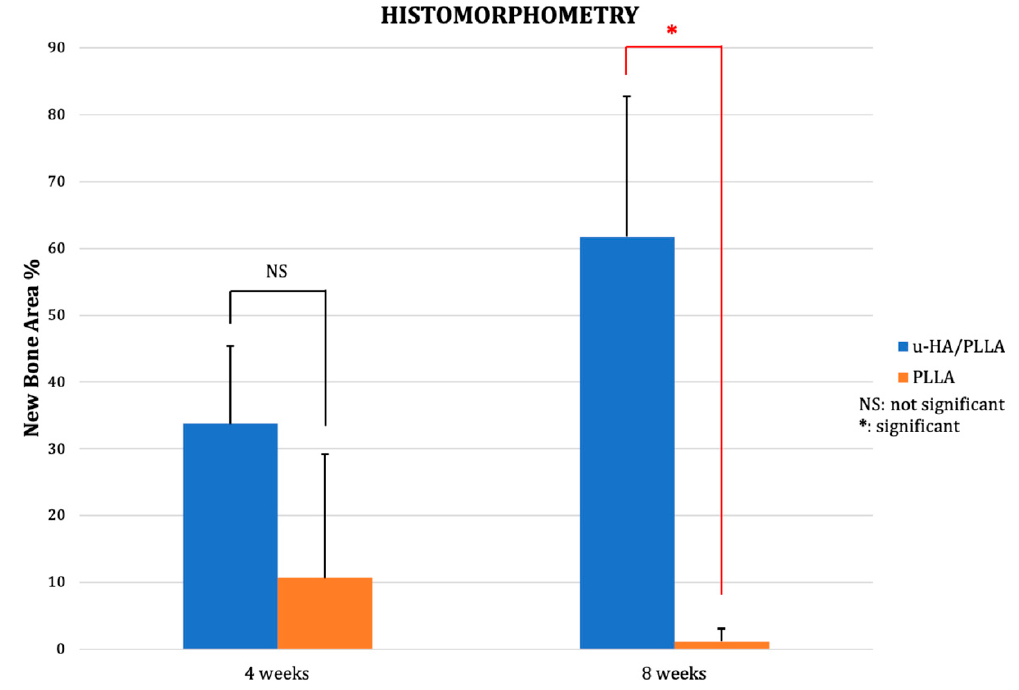
Figure 5. Percentage of new bone area in the u-HA / PLLA and PLLA groups at weeks 4 and 8. * p < 0.05.